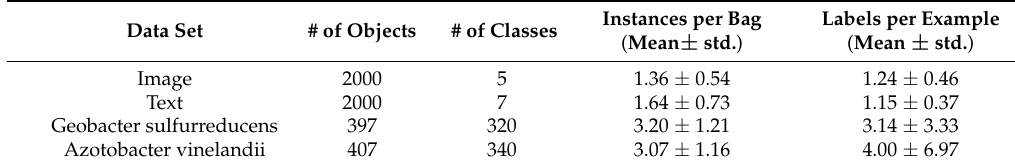
Table 1. The information of the datasets. std.: standard